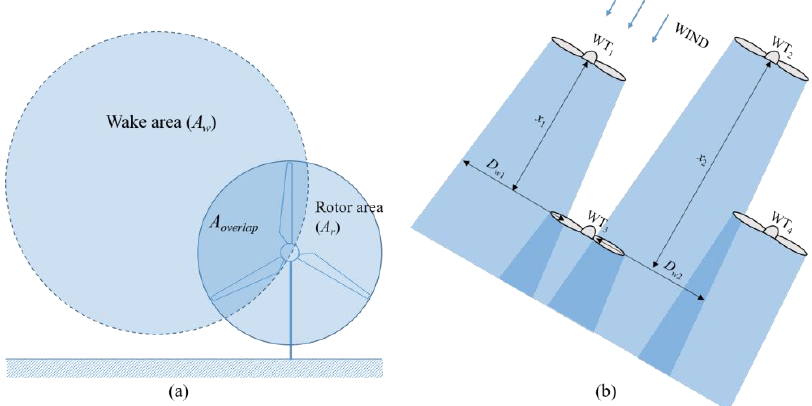
Figure 2. Partial and multiple wake e ff ects: ( a ) Overlap area between the wake and rotor areas; ( b ) Multiple wake according to wind direction.